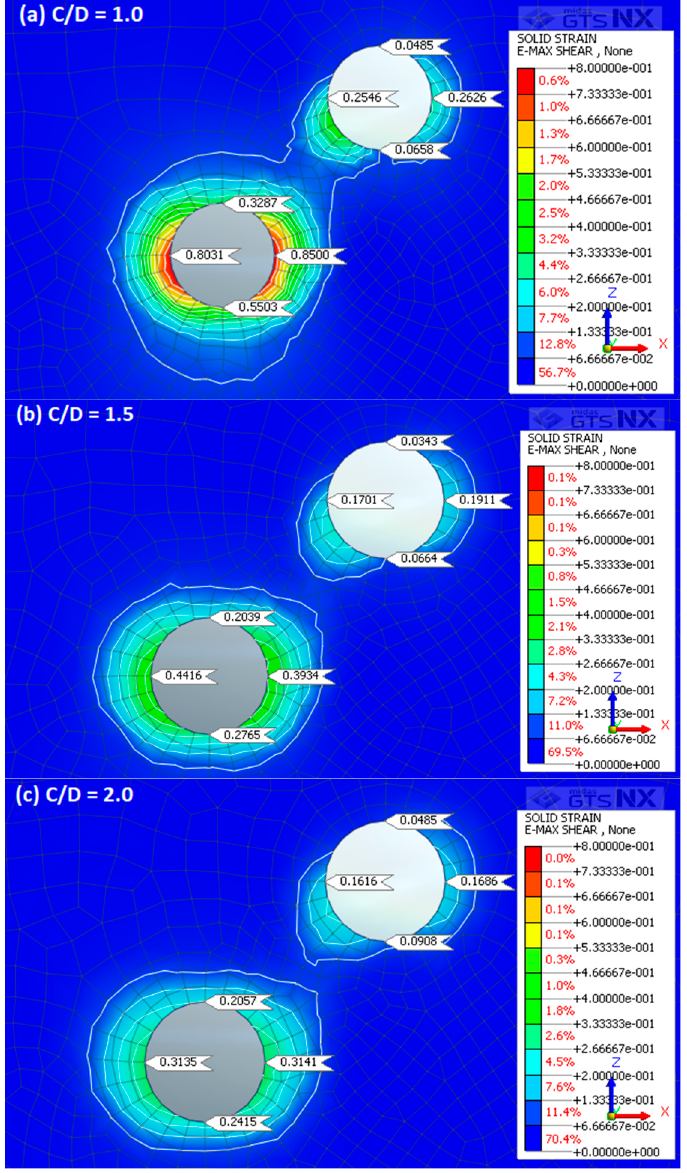
Figure 18. Effect of cover-to-diameter ratio on shear strain in the crown, invert, and springlines of twin tunnels at the end of excavation ( a – c ).